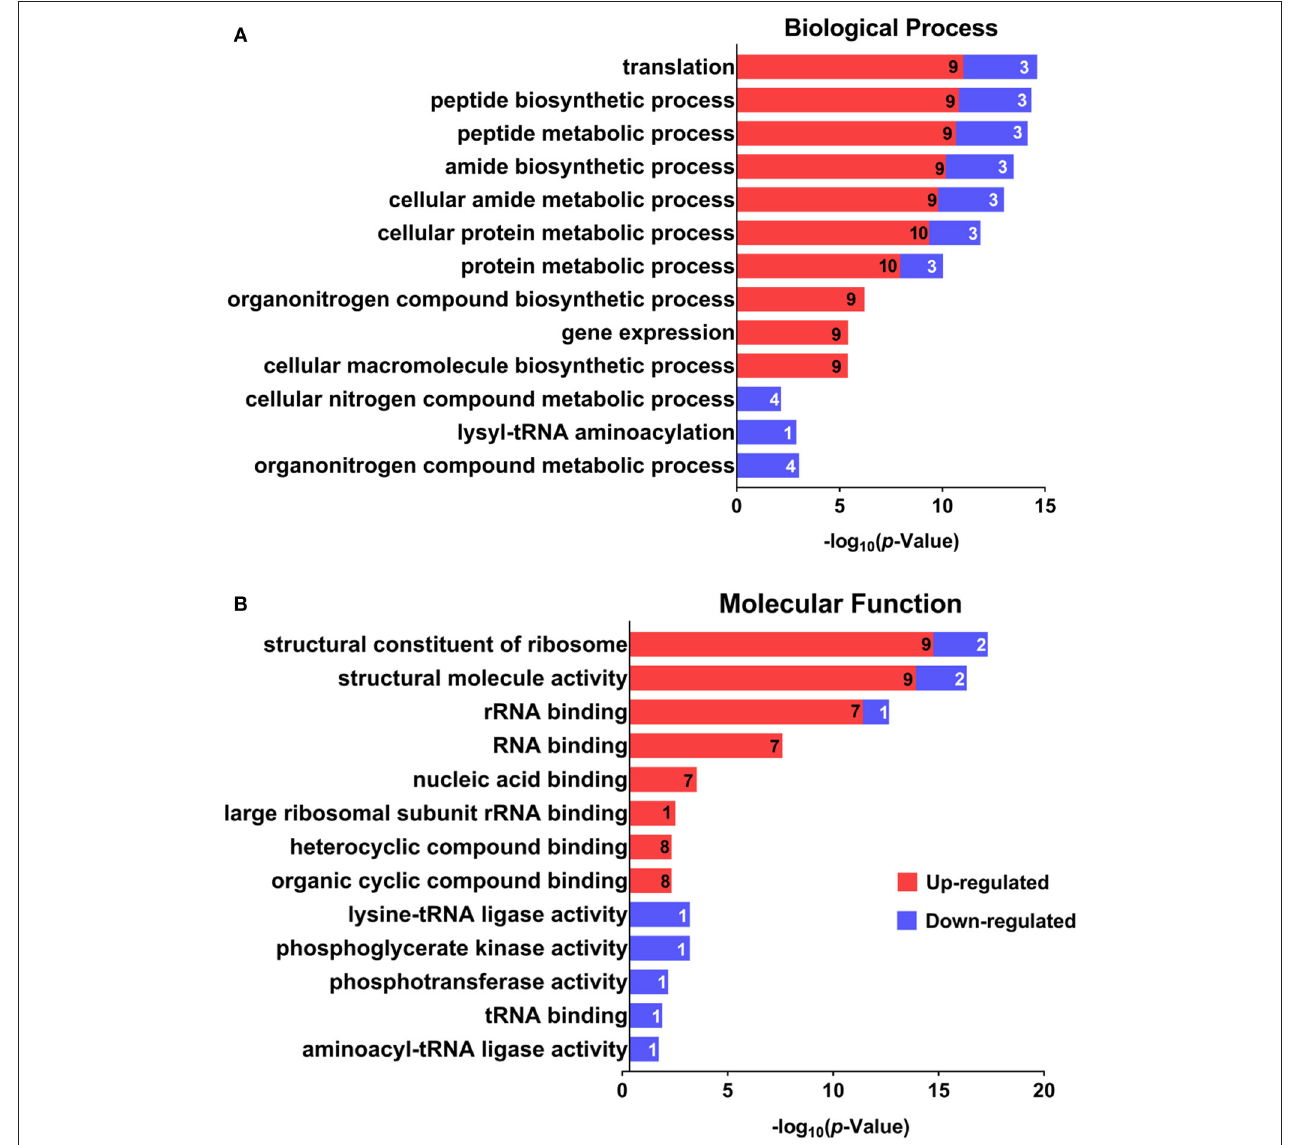
FIGURE 2 | GO analysis of differentially expressed proteins. GO analysis of differentially expressed proteins in A. hydrophila and A. hydrophila-R . Red color bars indicate upregulated proteins and blue color bars indicate downregulated proteins related to biological processes (A) and molecular functions (B) . Explanatory information on the functional enrichment and numbers of involved proteins are all listed on the left and right, respectively, behind the bars. Terms of the same category are grouped by P -values and shown on the y-axis (log 10 scale on the y-axis).